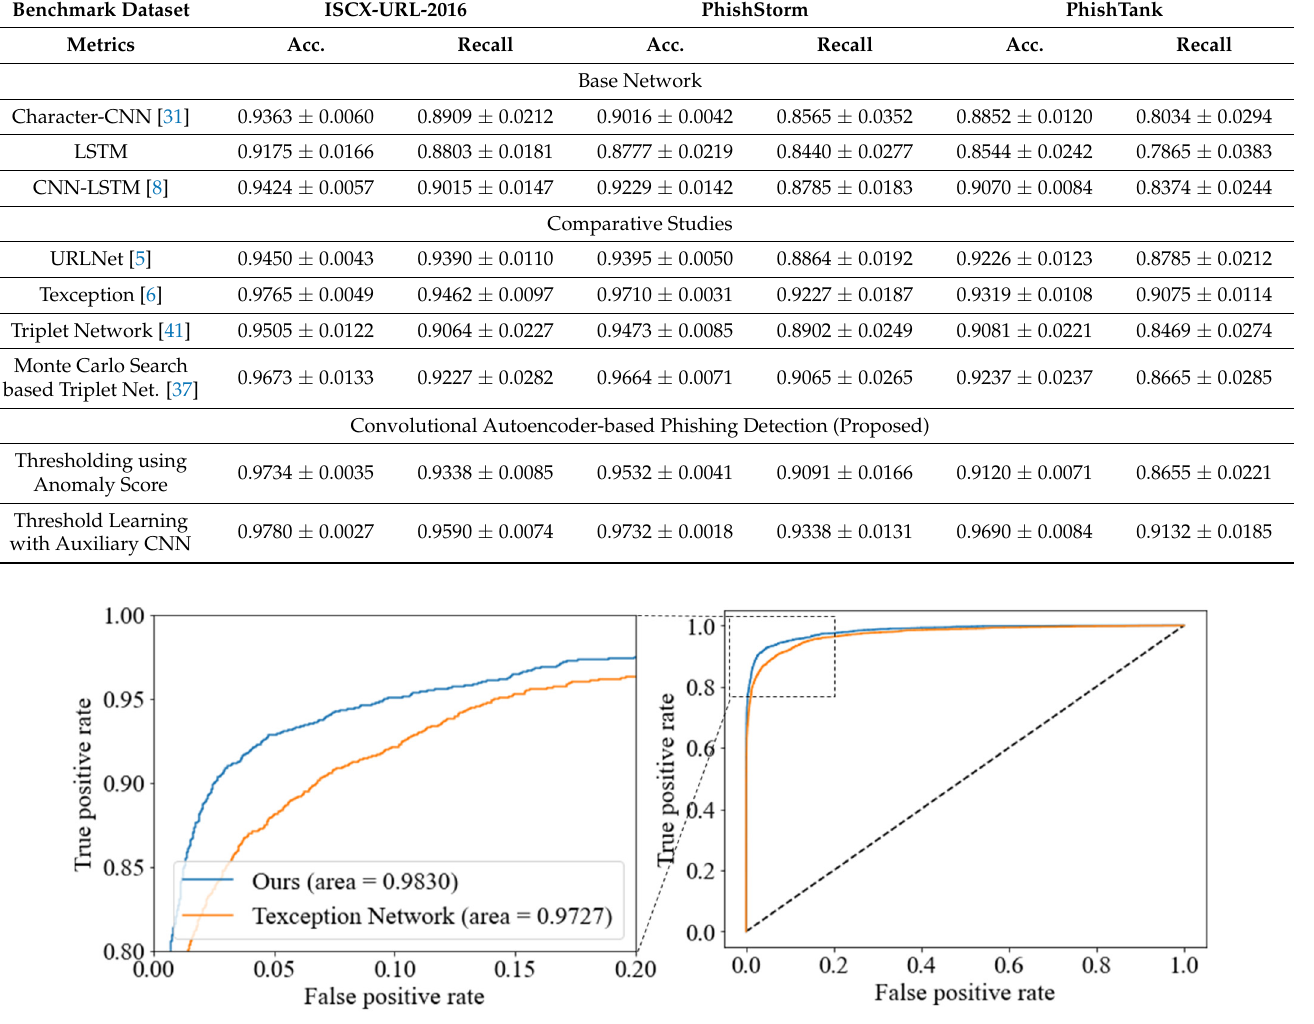
Figure 7. Robustness of accuracy and recall by class imbalance ratio. Table 5. Confusion matrix analysis to verify the effectiveness of the auxiliary classifier. Confusion Matrix